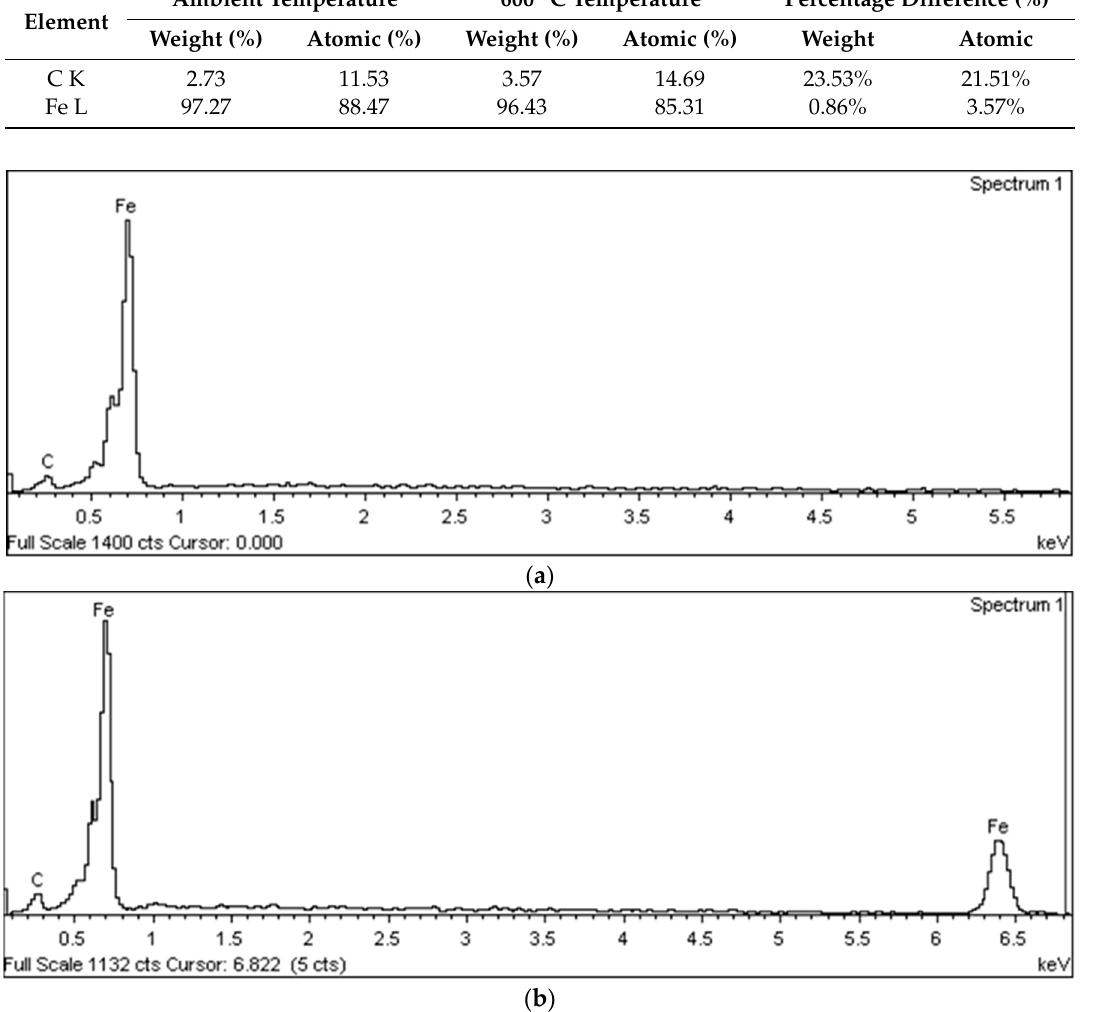
Figure 10. The EDX spectrum of CFS on ( a ) ambient temperature and ( b ) 600 °C temperature. Column shape could have a significant effect on the temperature and failure time of a column.